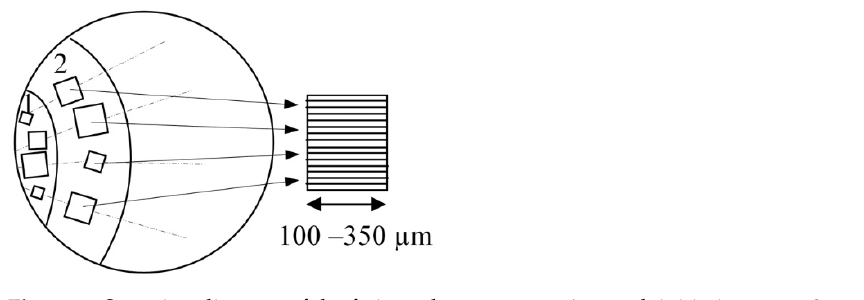
Figure 4. Scanning diagram of the fatigue damage zone: 1—crack initiation zone; 2—crack propagation zone.